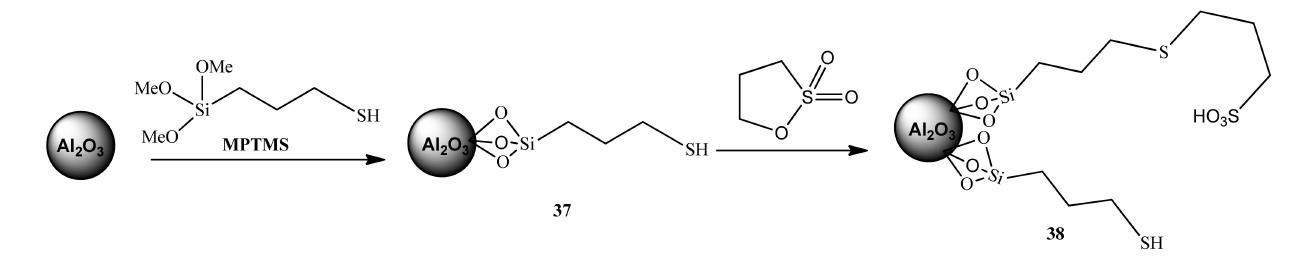
Figure 14. Bifunctional functionalized mesoporous Al 2 O 3 from ref